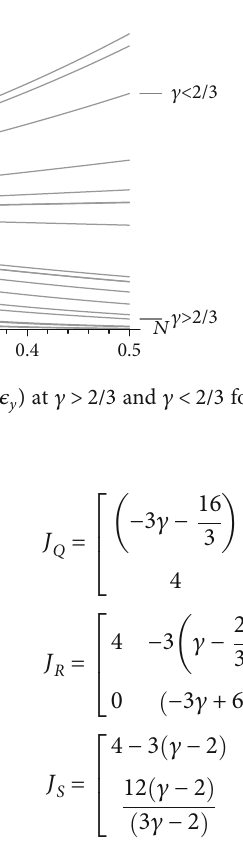
0.20.2 Figure 1: Shows the variation of perturbations along the x -axis ( ϵ Plot for 𝜀 y against N P ’ 𝜀 y